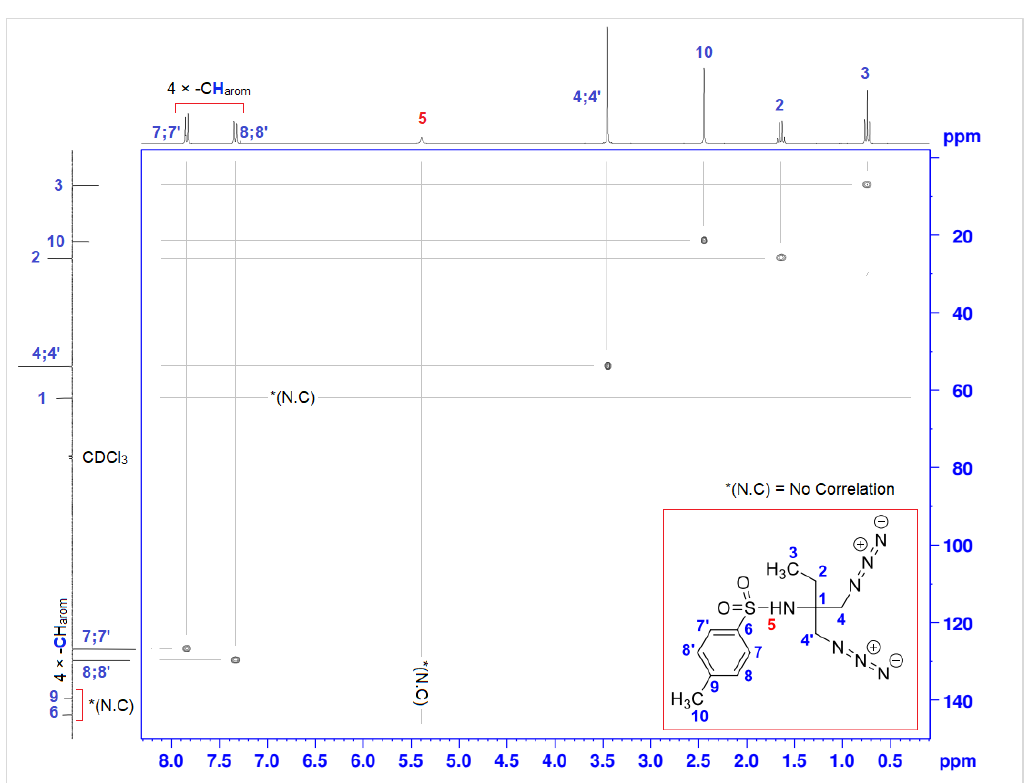
Figure 2. 2D HSQC spectrum of compound ( 3 ). “*”: No correlation.